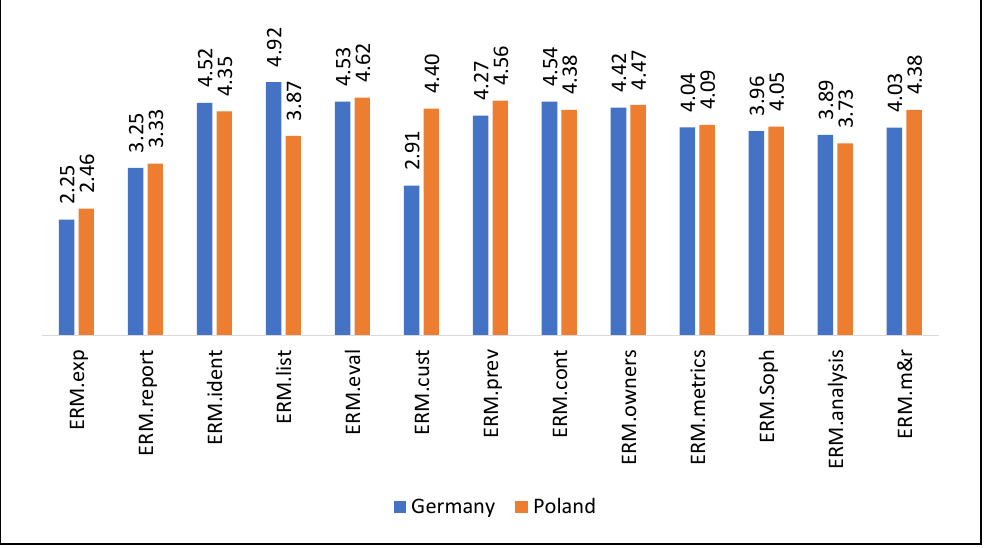
Figure 3. ERM sophistication construct: Survey results for SMEs in Germany and Poland. Table 7. ERM sophistication construct: SMEs in Germany vs. SMEs in Poland. Variable U